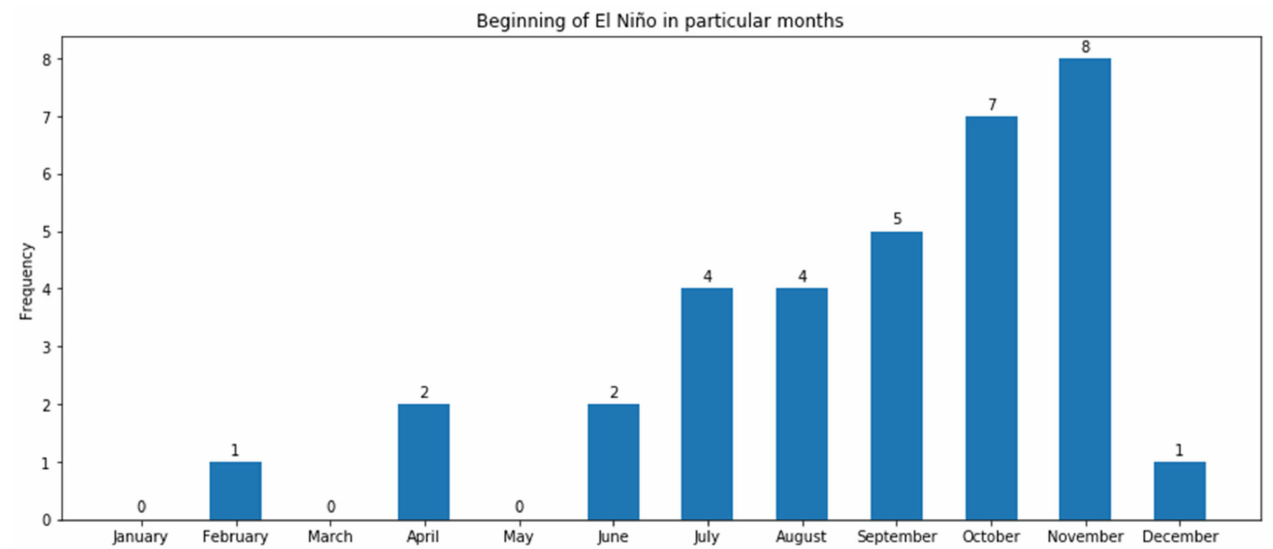
Figure 8. Occurrence of the beginning of El Niño episodes. Data from Table S1 and Figure 2. Once a month, NOAA provides updates on the ENSO evolution status (using ONI) https://www.cpc.ncep.noaa.gov/products/analysis_monitoring/lanina/enso_evolution-